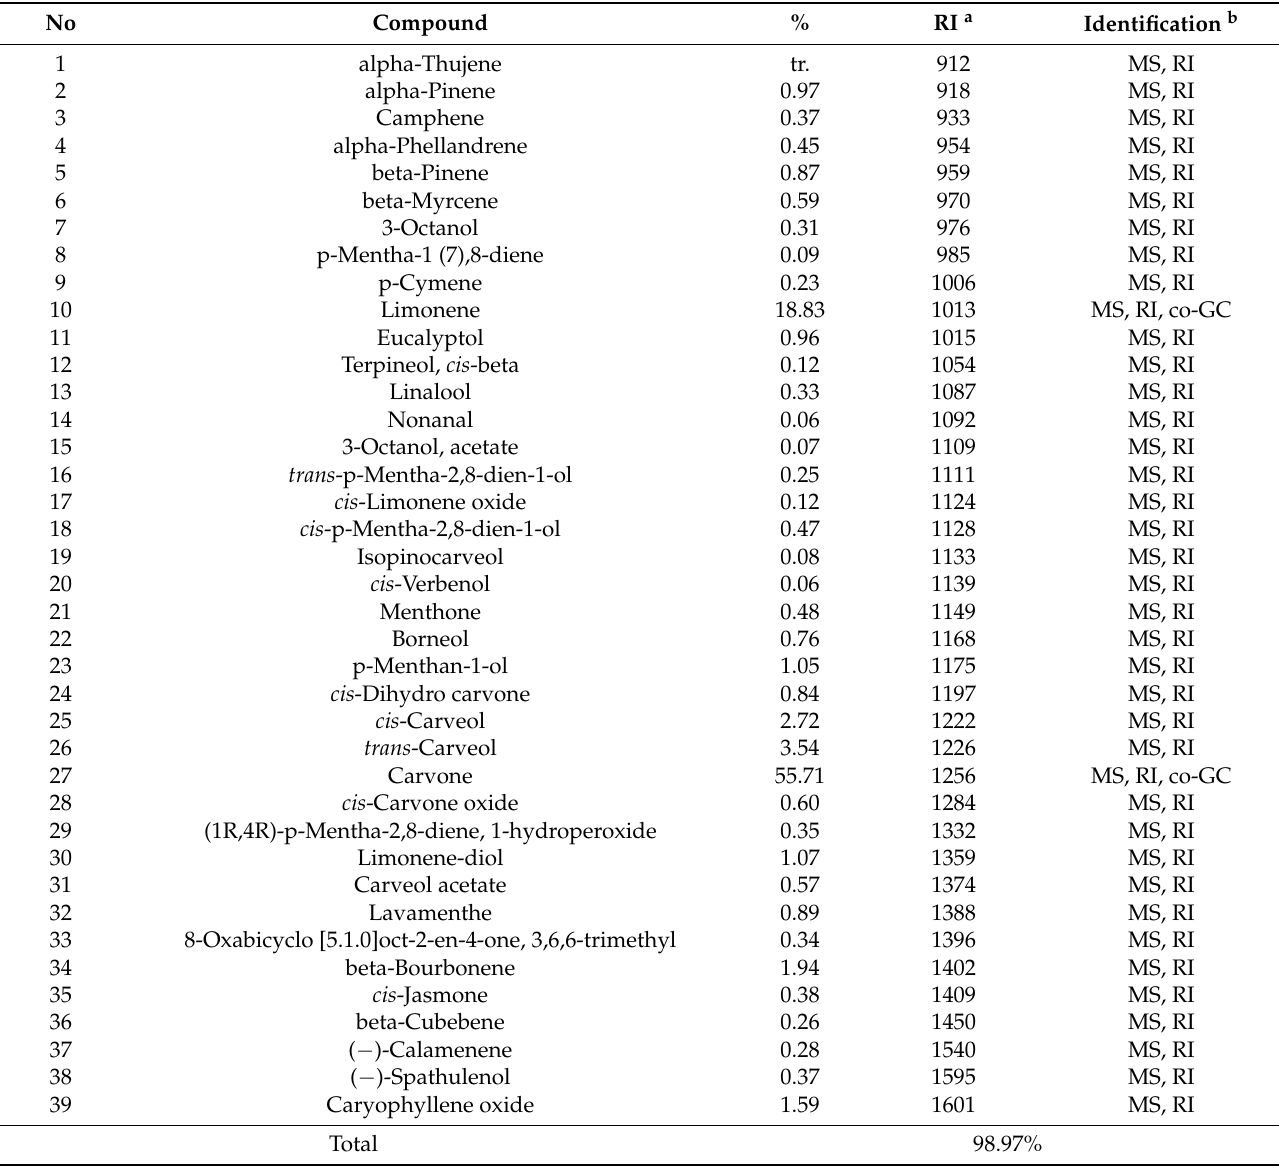
Table 2. Components of essential oil (EO) from M. smithiana growing in Western